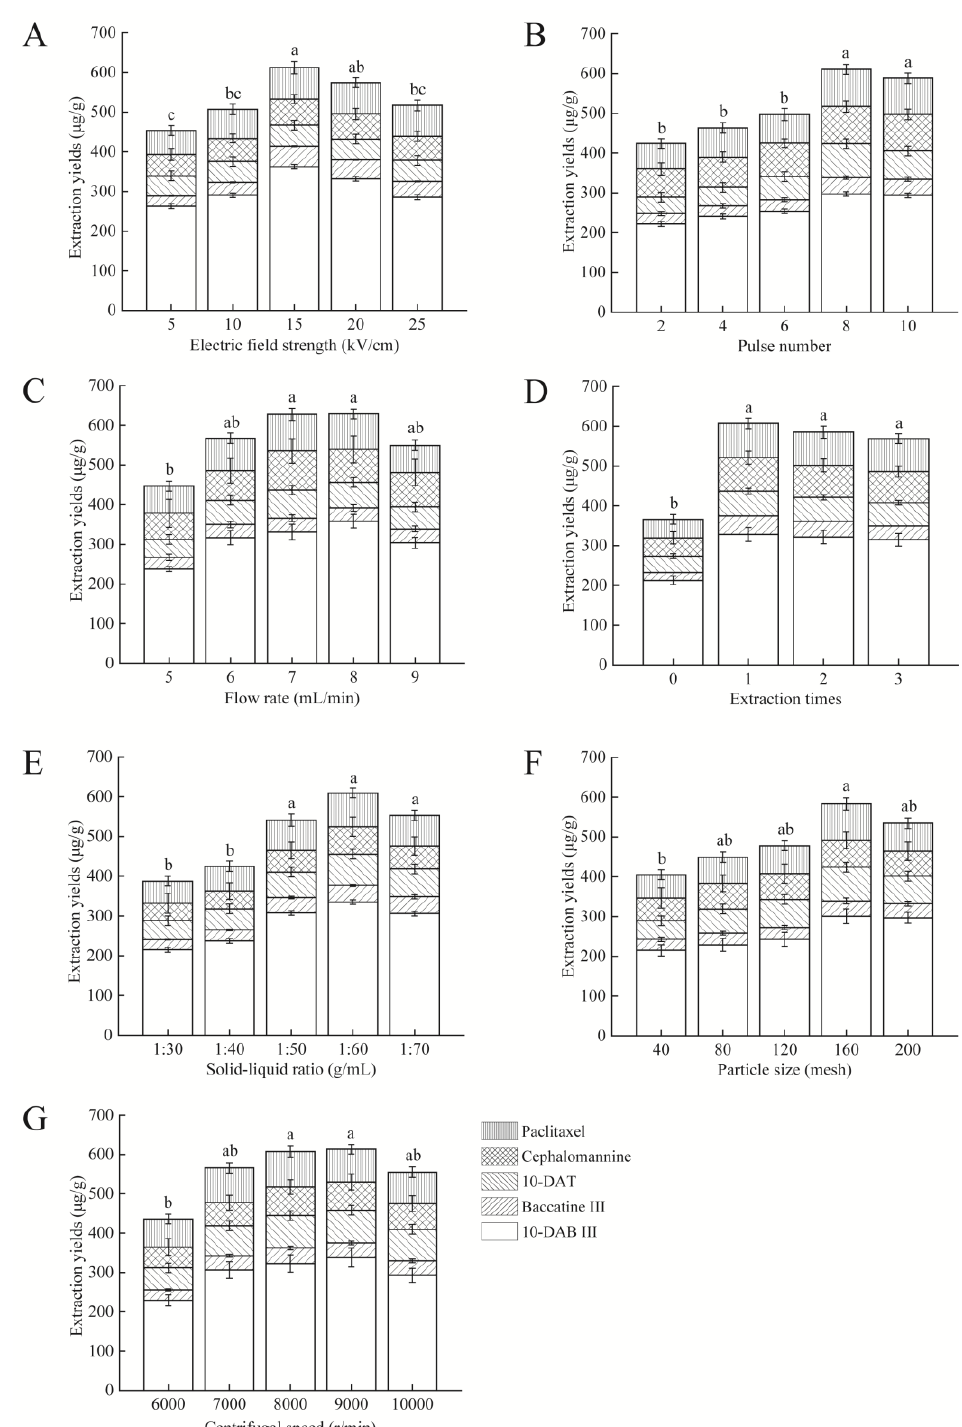
Figure 2. Effects of electric field strength ( A ), ( B ) pulse number, ( C ) flow rate, ( D ) number of extractions, ( E ) solid–liquid ratios, ( F ) particle size, and ( G ) centrifugation speed on extraction yields of five main taxanes in Taxus cuspidata . All data are presented as mean ± standard deviation. Data were collected from three independent experiments and analyzed using one-way analysis of variance. Different letters (a, b, c) in the same figure indicate significant differences ( p < 0.05).